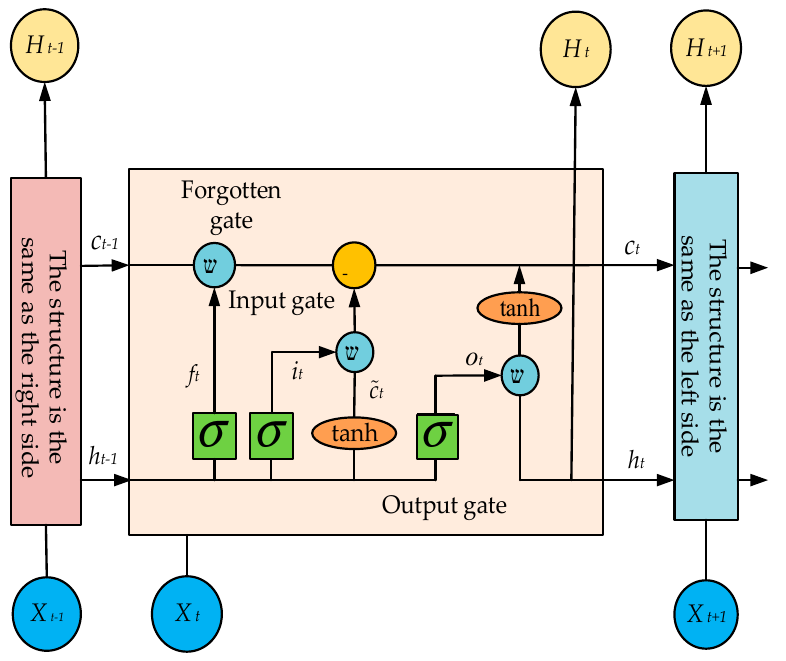
Figure 3. A diagram of the structure of the LSTM-NN model.